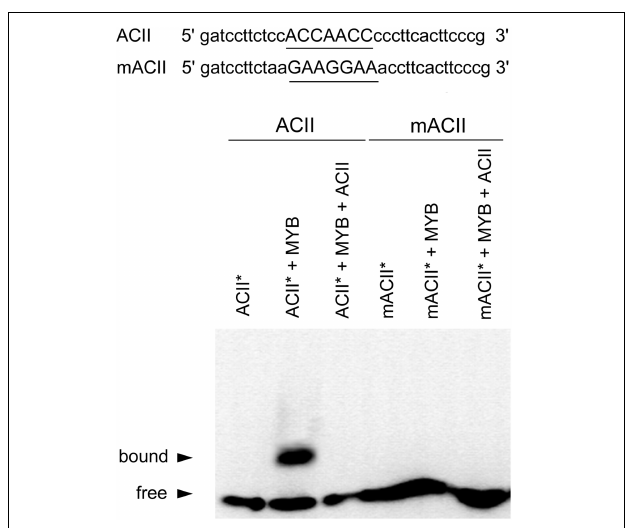
FIGURE 3 | Analyses of CcMYB12 protein binding to AC elements. EMSA output of the purified recombinant CcMYB12 binding to the AC element ACII (left) or to its mutated counterpart (mACII). The biotin-labeled free probe (ACII ∗ ) without added protein is designed as control. Binding of recombinant CcMYB12 to biotin-labeled probe ACII ∗ can be outcompeted by cold competitor ACII. Nucleotide sequences of probes are shown on the top of the figure. The AC or mAC element is